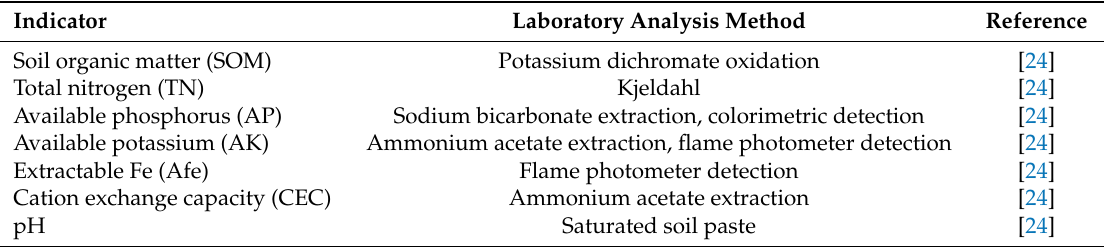
Table 2. Methods used in laboratory analysis for selected